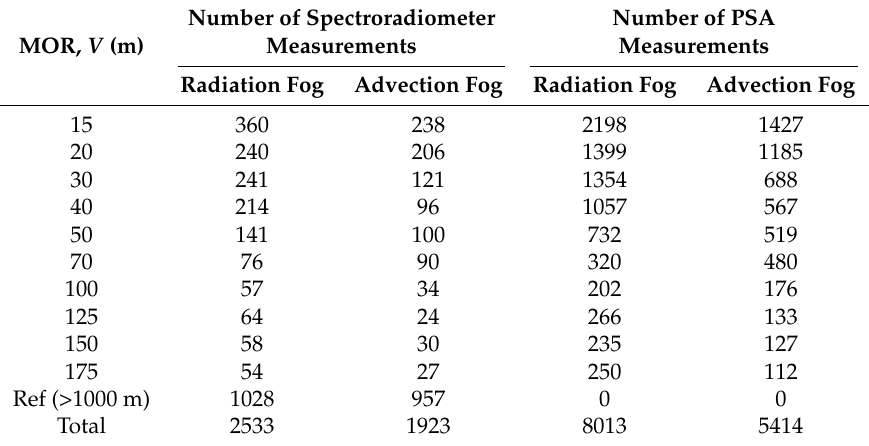
Table 1. Statistics on the number of measurements made during the tests. Spectroradiometer data were collected at a variable time step depending on the conditions (a few seconds). The PSA data were collected at a time step of one second.